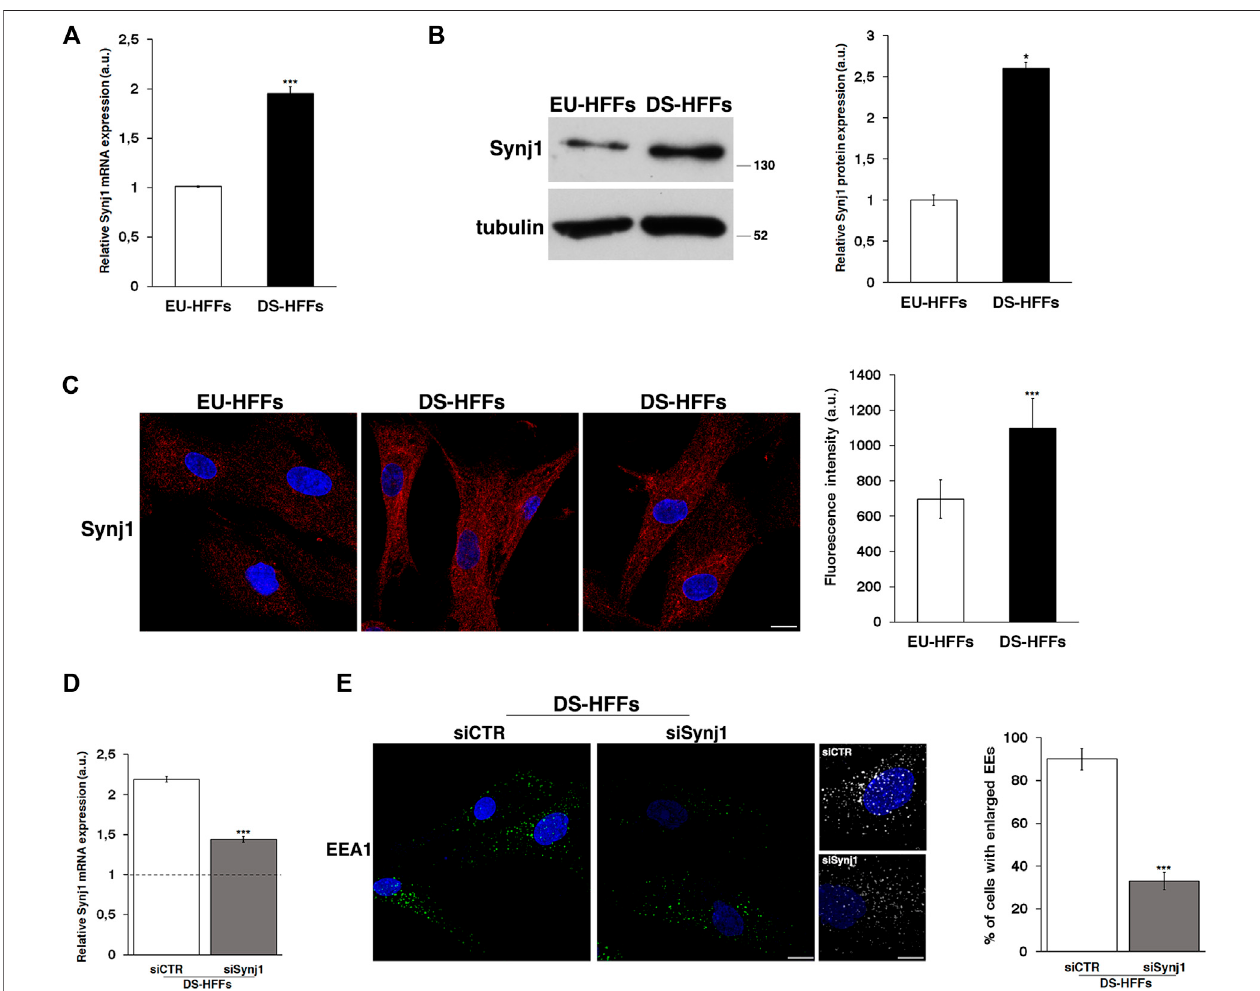
FIGURE 5 | Synj1 is overexpressed in fetal trisomic fi broblasts. (A) Synj1 mRNA expression in EU-HFFs and DS-HFFs was analyzed by qRT-PCR. Results are presented as the mean ± SD of three independent experiments performed in triplicate. (B) Representative immunoblotting of Synj1 in EU-HFFs and DS-HFFs. Tubulin wasusedastheloadingcontrol.Themolecularweightofproteinmarkersisindicated.Densitometricanalysisofthreedifferentexperimentsisshown.Errorbars,means± SD. (C) ImmunostainingofSynj1inEU-HFFsandDS-HFFsisshown.Scalebar,8 μ m.Mean fl uorescenceintensity(arbitraryunit,a.u.)ofSynj1ishigherinDS-HFFs than in EU-HFFs. (D) DS-HFFs were transiently transfected with scrambled (siCTR) or speci fi c anti-Synj1 (siSynj1) siRNA and relative Synj1 mRNA expression was measuredbyqRT-PCR.Resultsarepresentedasthemean±SDoftwoindependentexperimentsperformedintriplicate. (E) EarlyendosomesofsiCTRandsiSynj1DS- HFFswerelabelledwithEEA1antibody,detectedwithAlexa-488-conjugatedsecondaryantibodies.Serialconfocalsectionswerecollectedfromthetoptothebottomof the cells. Representative images and corresponding 3D reconstructions showing that the attenuation of Synj1 restores the EEs aberrant phenotype. Scale bars, 8 μ m. The graph shows the percentage of cells displaying enlarged EEA1-positive dots. The bars show the relative mean value ± SD of two independent experiments, n ≥ 30 cells. * p < 0.05; *** p < 0.001, Student ’ s t